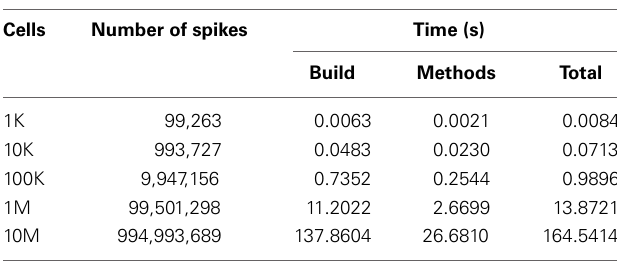
Table 3 | Benchmark results for HRLAnalysis ™